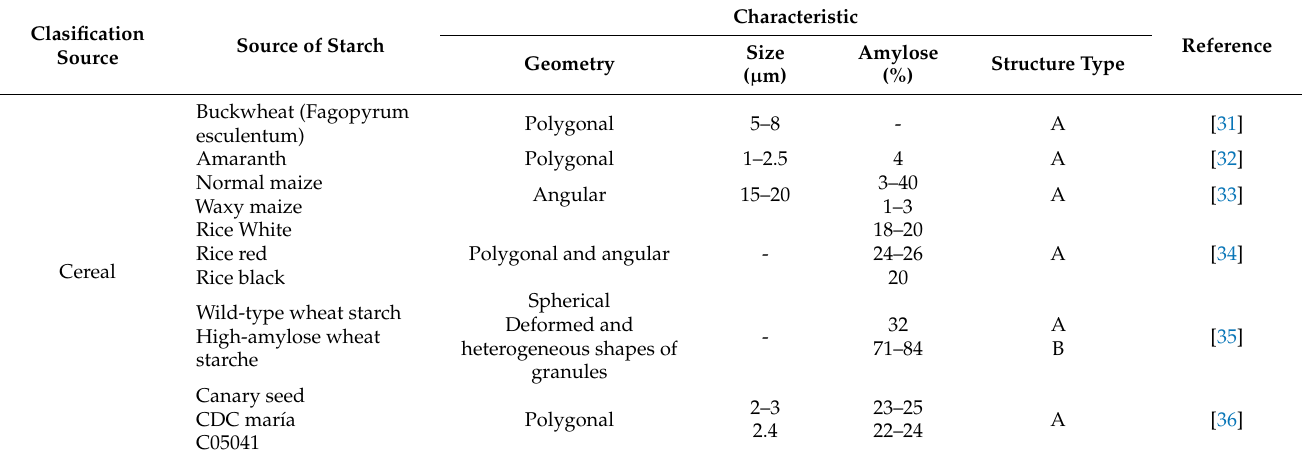
Table 1. Characteristics and source of starch